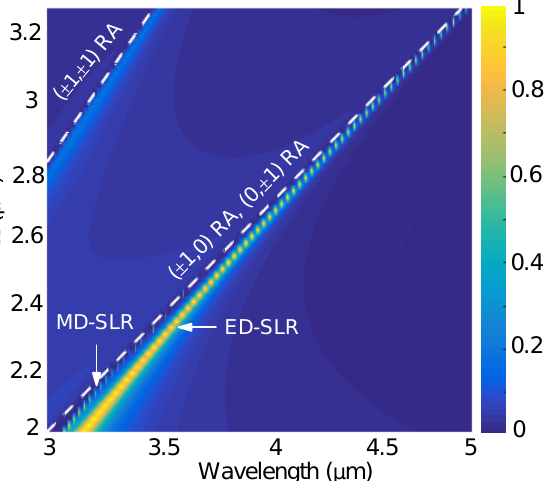
Figure 4. Simulated reflectance spectra for different periods. Note that, under normal incidence, RAs of the ( ± 1,0 ) and ( 0, ± 1 ) orders degenerate into one curve.